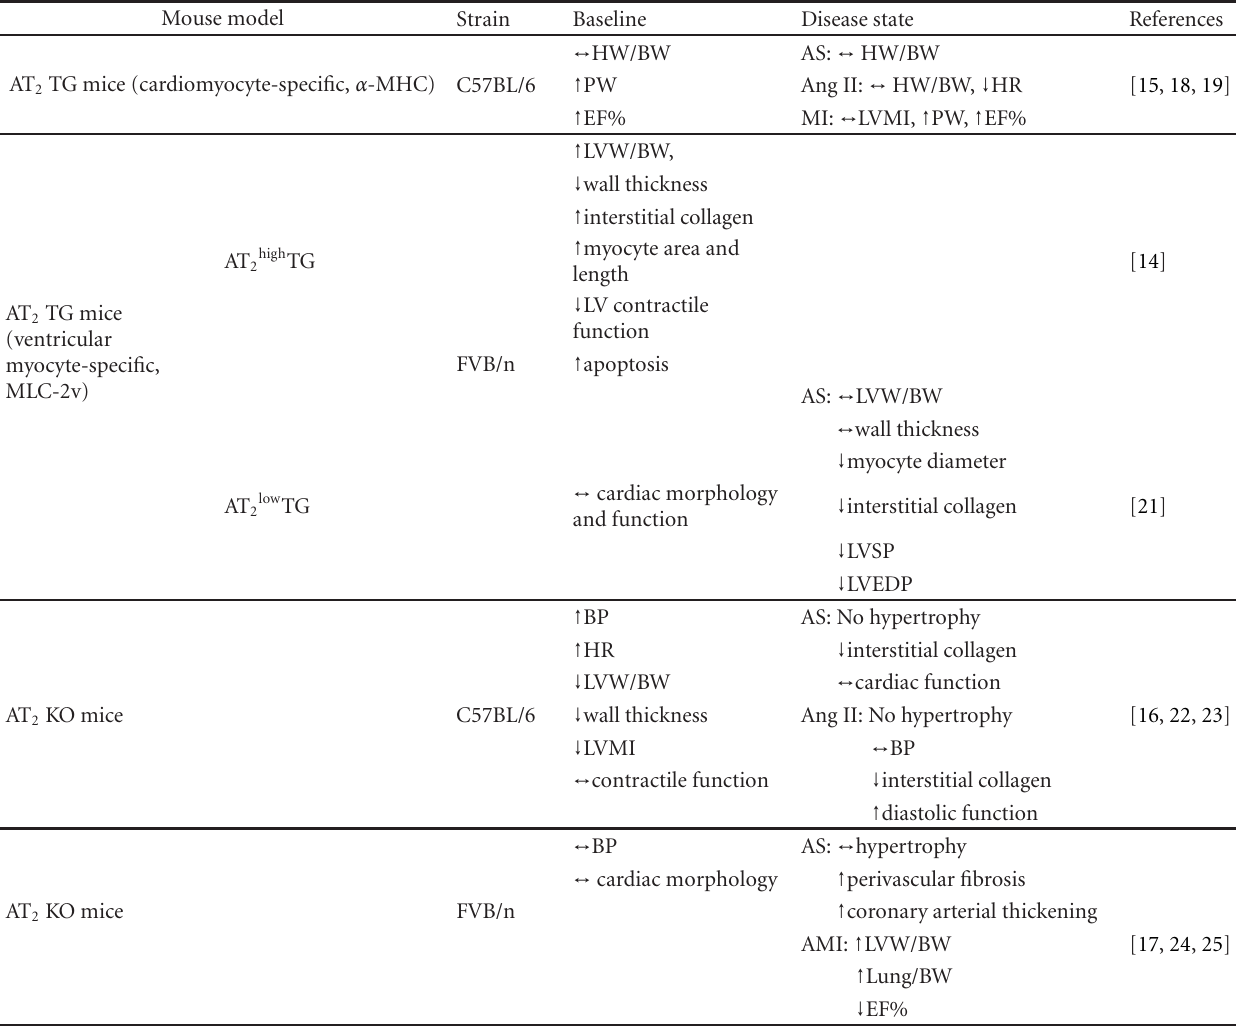
Table 1: Cardiac phenotype and function in mice with AT2 overexpression (TG) or knock out